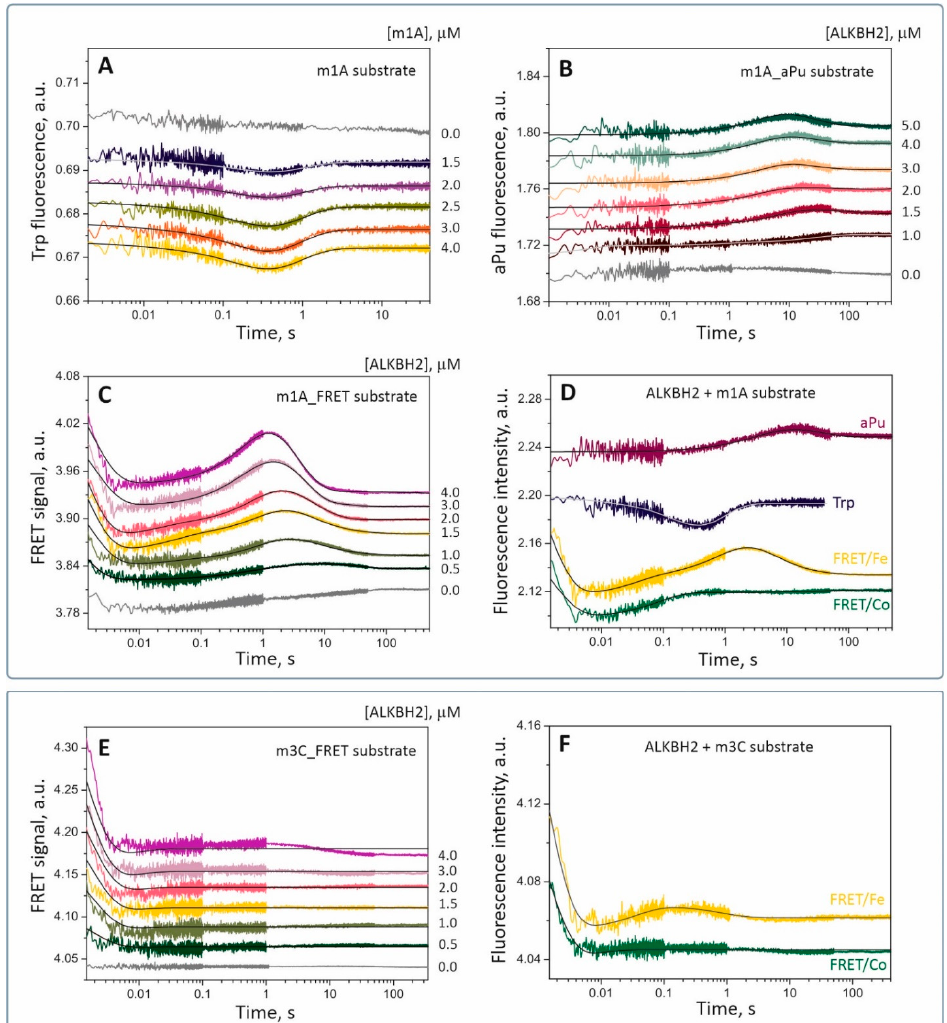
Figure 5. Interactions of ALKBH2 with m1A- and m3C-containing DNA as measured by the SF method. ( A ) Time courses of Trp fluorescence intensity obtained for 2 μ M enzyme and various concentrations of substrate m1A. ( B ) Time courses of aPu fluorescence intensity obtained for 2 μ M aPu-containing substrate m1A and various concentrations of ALKBH2. ( C ) Time courses of the FRET signal generated by the FAM/BHQ1 pair in the presence of 1.5 μ M DNA substrate and various concentrations of ALKBH2. Gray curves represent control experiments where the fluorescent component was mixed with the buffer. ( D ) A comparison of SF analysis-derived kinetic curves for different fluorophores and metals in the course of demethylation of substrate m1A. Experimental data on Trp, aPu, and FRET are highlighted in dark blue, wine, and yellow, respectively. The green curve was obtained during interactions of ALKBH2 and a methylated substrate in the presence of Co(II) as a cofactor. ( E ) Time courses of the FRET signal obtained for 1.5 μ M substrate m3C and various concentrations of ALKBH2. ( F ) A comparison of FRET kinetic curves between cofactors Fe(II) and Co(II) as measured in the course of interactions between ALKBH2 and substrate m3C. For each set of curves, jagged traces represent experimental data. Smoothed curves were obtained via global fitting to kinetic Schemes 1 and 2.